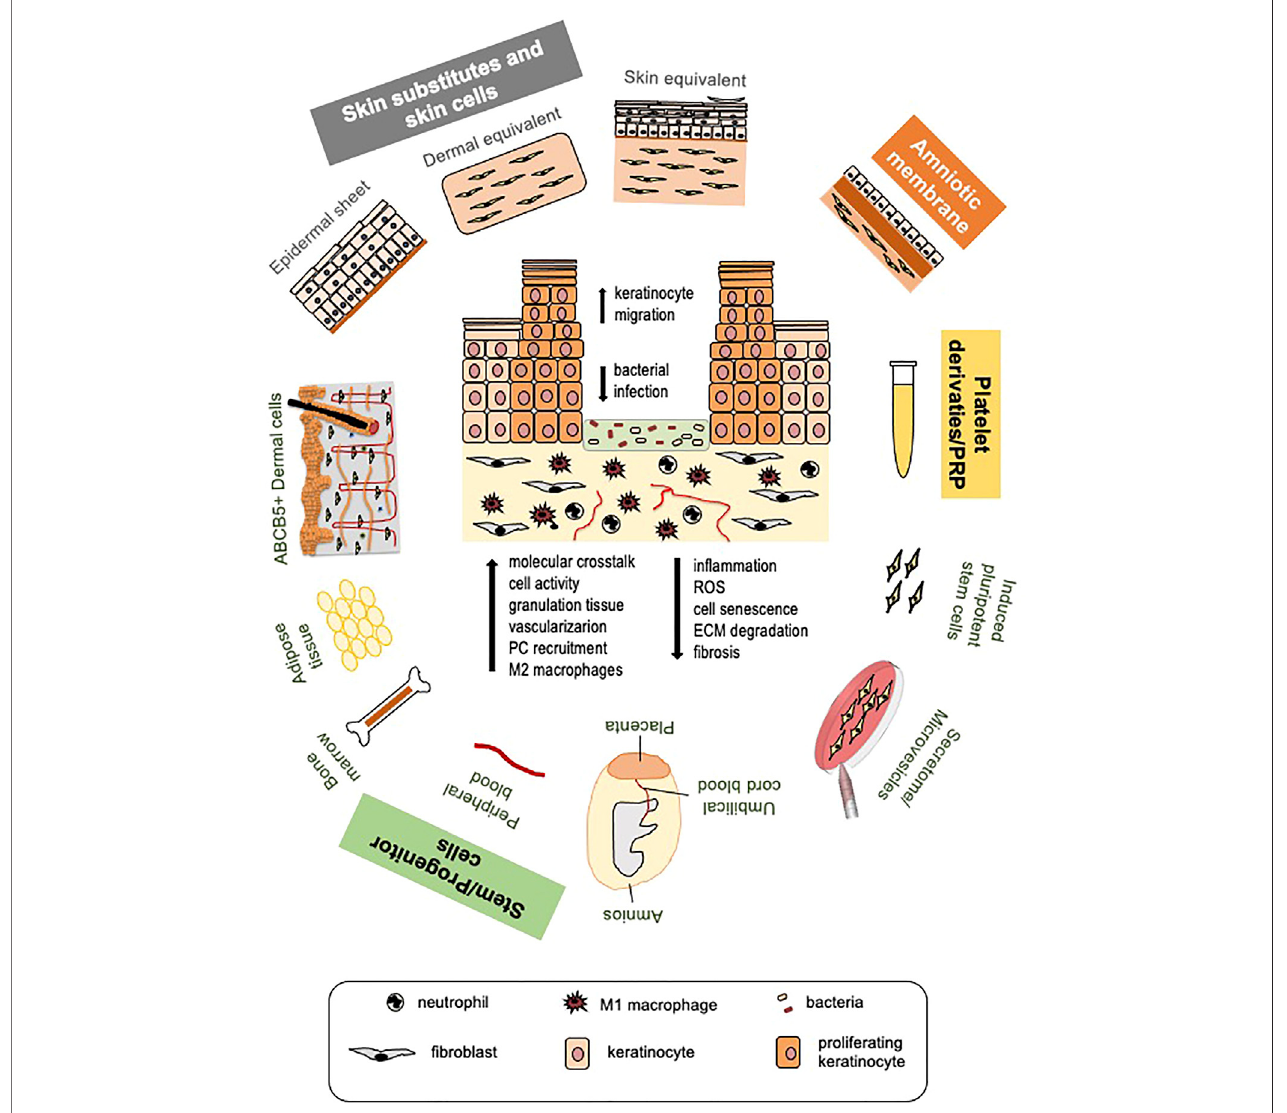
FIGURE 1 | Cell and platelet-derived tools for diabetic ulcer therapy. Different cell or platelet-derived tools with the bene fi cial effects they elicit on diabetic wound healing (a diabetic ulcer schematic is depicted in the center). Skin cells and skin substitutes, stem cells of different origin and their secretome, platelet derivatives and platelet-rich plasma (PRP) are all potential tools to promote healing of diabetic ulcers. Induced pluripotent stem cells (iPSCs) derived from fi broblasts are promising therapeutic tools for improving autologous and possibly allogeneic cell therapy, not yet tested at clinical level. Therapeutic tools are applied after routine removal of necrotic tissue and antiseptic treatments. Bene fi cial effects of all approaches are largely due to cell ability to release great amount of growth factors, cytokines and chemokines, and other biomolecules; for this reason, MSC secretome and released microvesicles are being tested as cell-free, safer therapeutic approaches. These therapies increase the molecular crosstalk, promote cell function and, likely, circulating precursor cell recruitment. Re-epithelialization is stimulated due to enhanced keratinocyte migration; granulation tissue formation and vascularization are improved. Mesenchymal stem cells (MSCs), the amniotic membrane and PRP speci fi cally manifestimmunomodulatoryandimmunosuppressivepropertiesleadingtoreducedwoundin fl ammationandscartissueformation,allowingallogeneiccellandPRPuse without major adverse effects. (PC, precursors cells; ROS, reactive oxygen species; ECM, extracellular matrix).